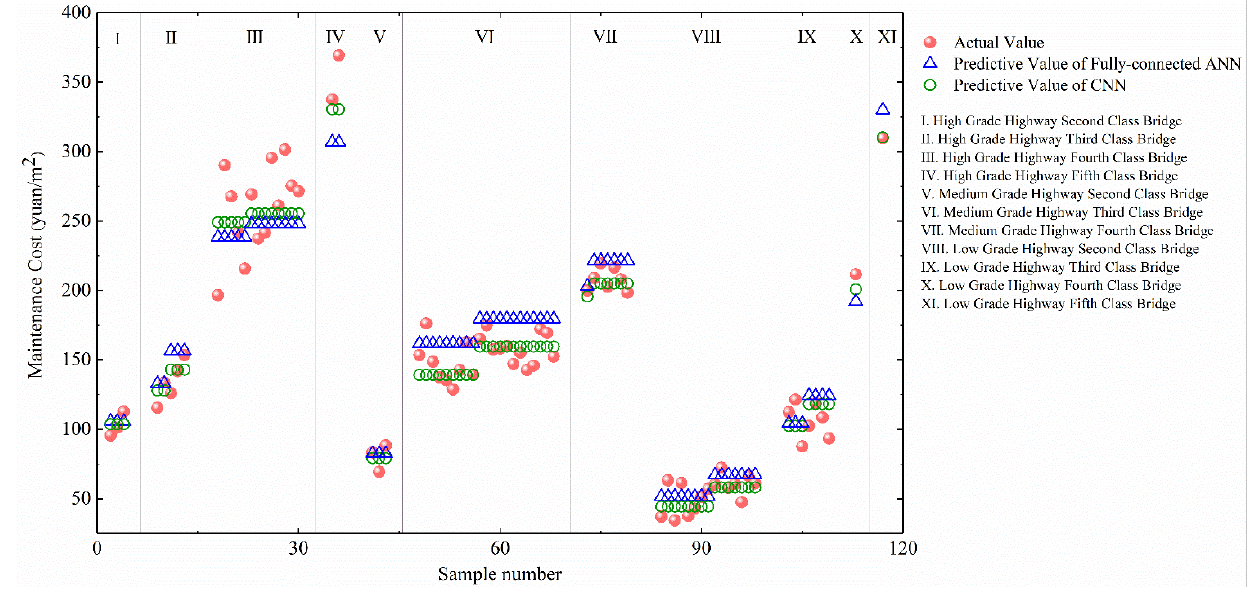
Figure 13. Comparison of actual maintenance costs and predicted results given by the fully-connected ANN model and the CNN model.